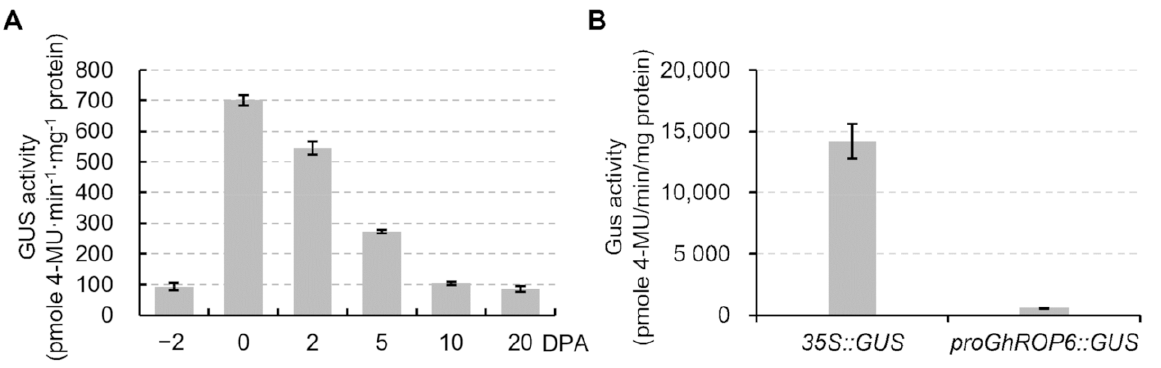
Figure 5. Strength of GUS activity in proGhROP6::GUS ovules. ( A ) GUS activity in developing ovules. Samples from − 2 to 2 DPA were fiber-bearing ovules, and those from 5 to 20 DPA were separated fibers. ( B ) Comparison of GUS activity in 0 DPA ovules between proGhROP6::GUS and 35S::GUS cottons. Error bars represent standard deviations of three biological